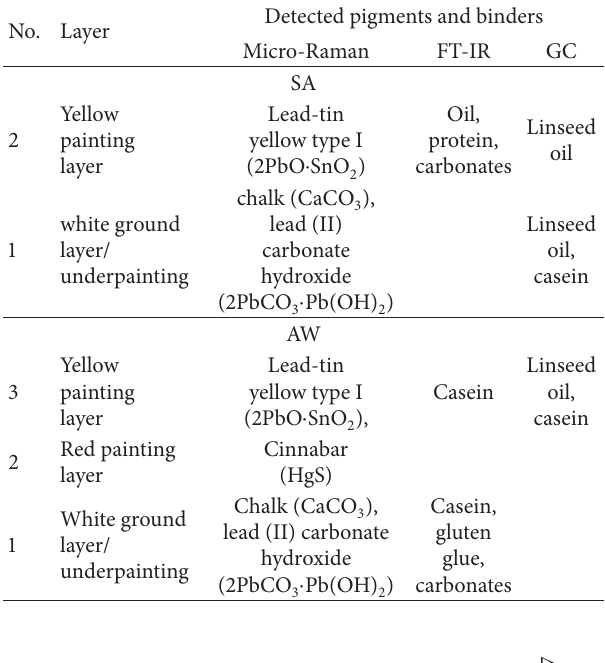
Table 1: Stratigraphy and results of the measurements of pigments and binders of a cross-section of the SA and AW samples.